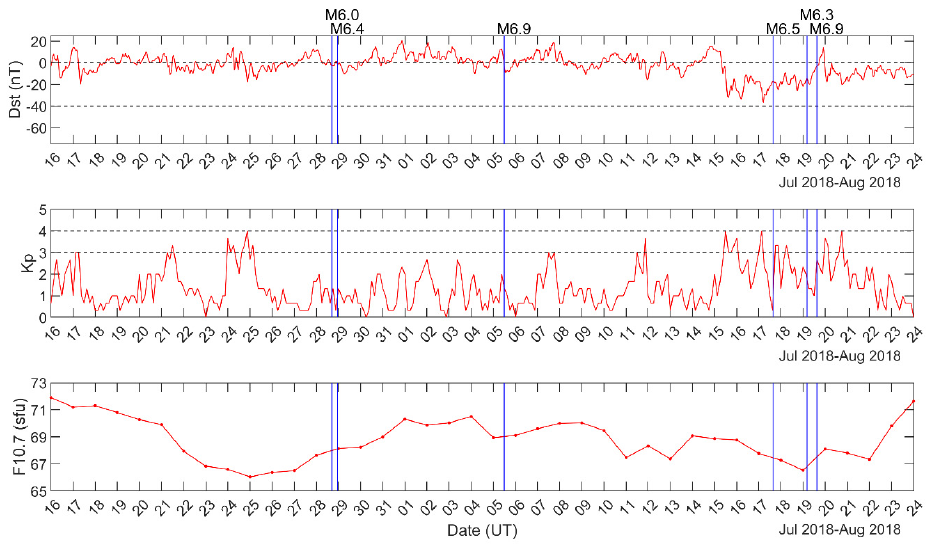
Figure 14. Temporal variations of Dst, Kp, and F10.7 during 16 July to 23 August 2018. The blue lines denote the time of six earthquakes during the period (1. M 6 at 17:07:23 on 28 July, 7.10 ◦ S, 122.73 ◦ E. 2. M 6.4 at 22:47:38 on 28 July, 8.24 ◦ S, 116.51 ◦ E. 3. M 6.9 at 11:46:38 on 5 August, 8.26 ◦ S, 116.44 ◦ E. 4. M 6.5 at 15:35:01 on 17 August, 7.37 ◦ S, 119.80 ◦ E. 5. M 6.3 at 04:10:22 on 19 August, and 8.34 ◦ S, 116.60 ◦ E. 6. M 6.9 at 14:56:27 on 19 August, 8.32 ◦ S, 116.63 ◦ E.). The time of the earthquake catalog is in UTC.